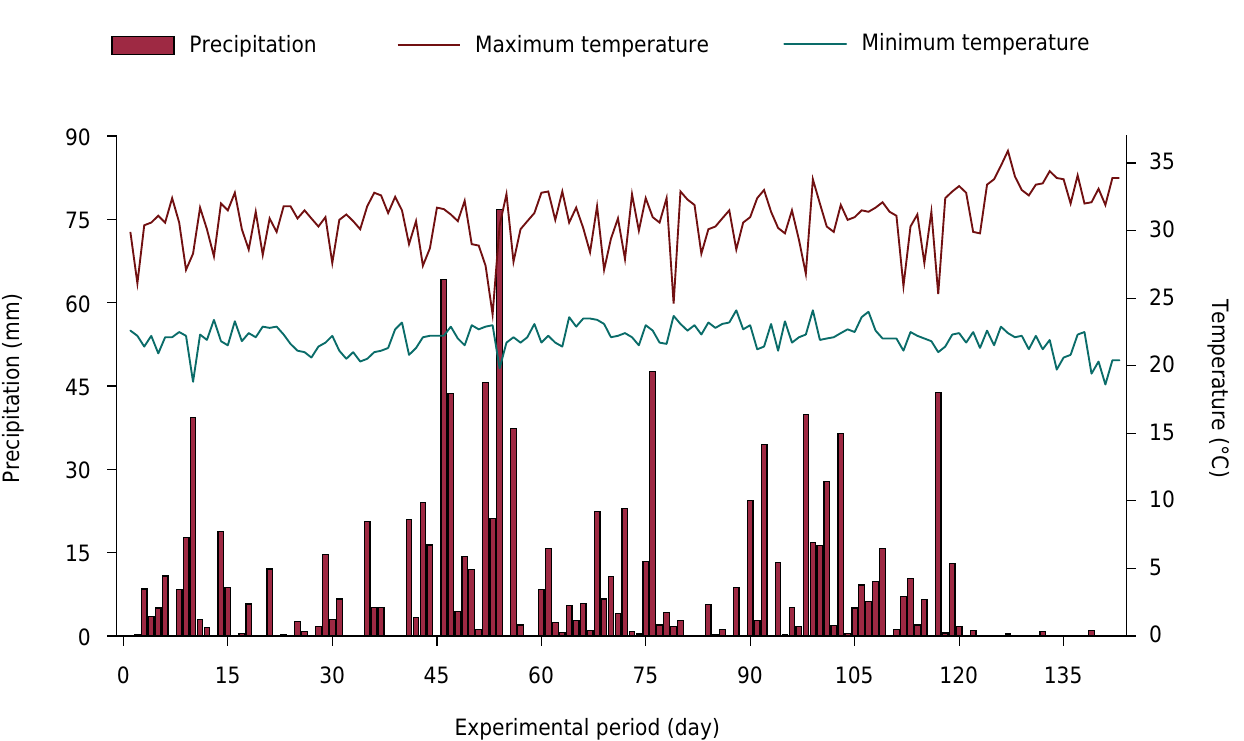
Figure 2. Precipitation and maximum and minimum temperatures of the experimental area during the period of conduction of the experiment in Araguaína-Tocantins State in the year of